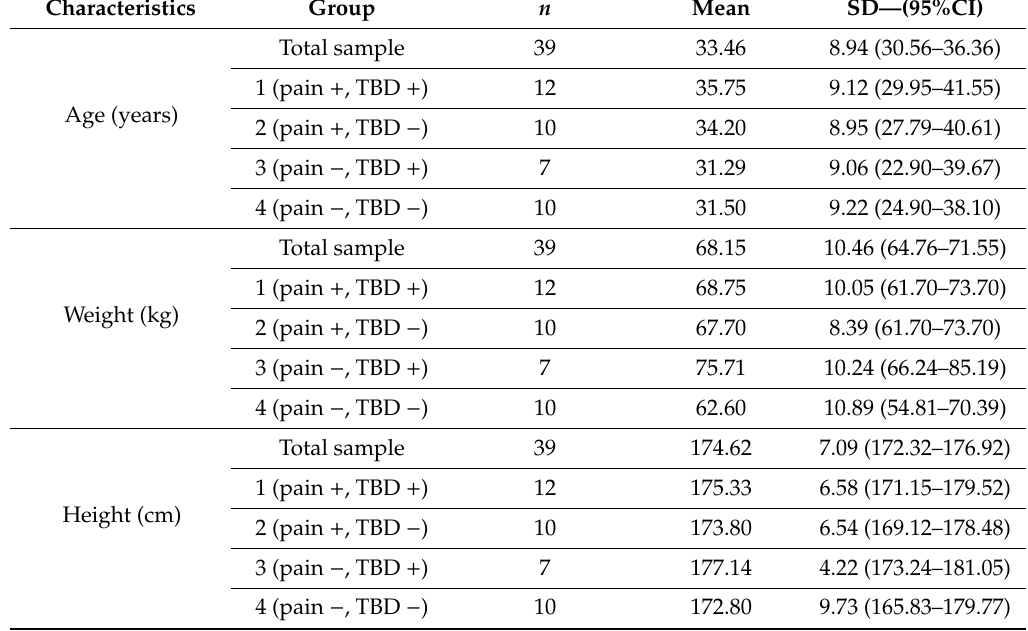
Table 1. Baseline epidemiological and general morphometric